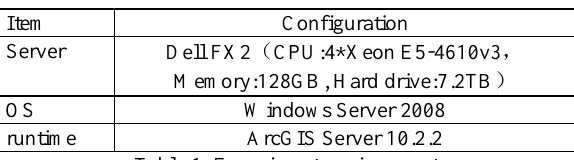
Table 1. Experiment environment